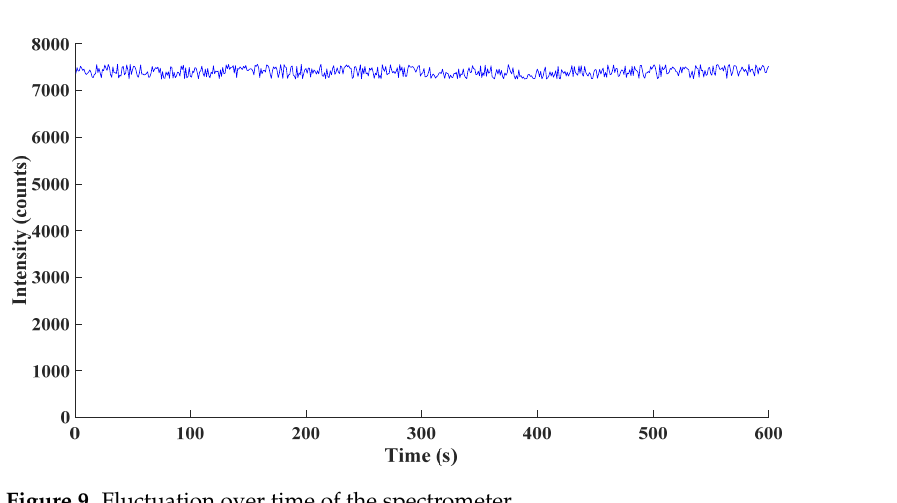
Figure 9. Fluctuation over time of the spectrometer.